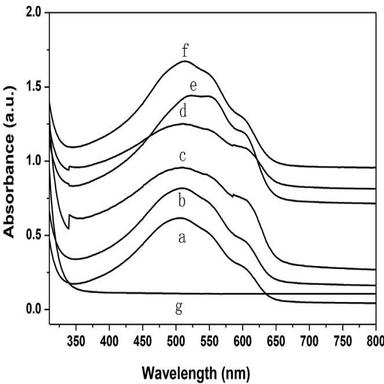
UV-vis spectrum (thin film) of P3HT-MWCNT prepared by click chemistry: (a) P3HT; (b) physical blends of P3HT and 1 wt% MWCNT; (c) physical blends of P3HT and 5 wt% MWCNT; (d) physical blends of P3HT and 10 wt% MWCNT; (e) physical blends of P3HT and 20 wt% MWCNT; (f) P3HT-MWCNT; (g) MWCNT.